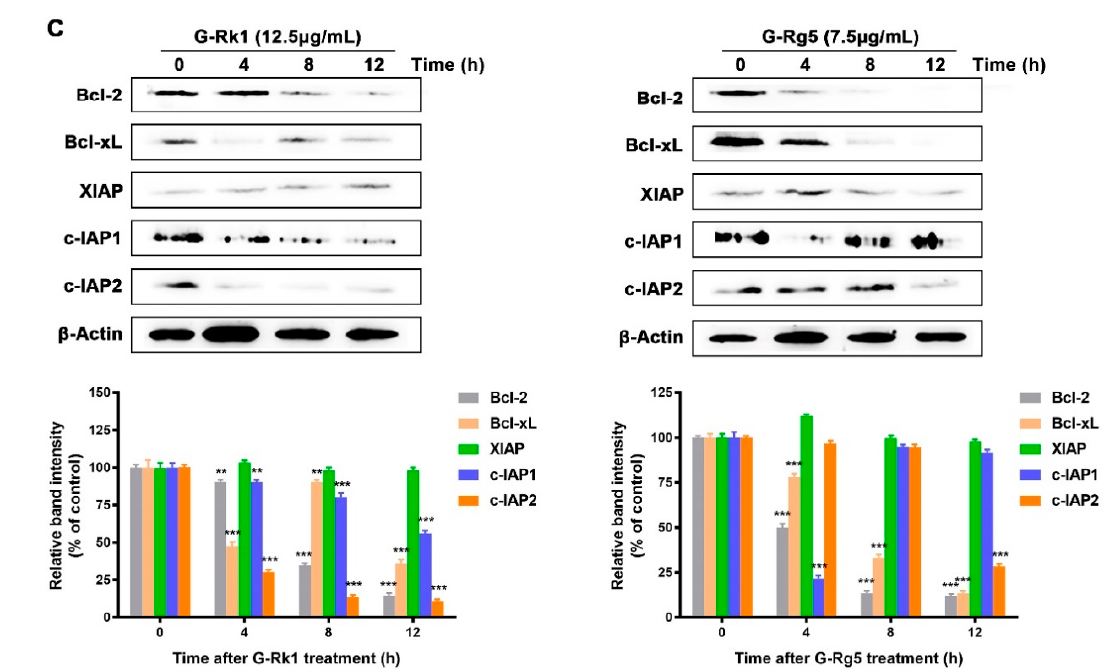
Figure 4. Activation of caspase-8, -9, -3 and analysis of anti-apoptotic protein levels in MHCC-97H cells treated with G-Rk1 or G-Rg5. ( A ) MHCC-97H cells were treated with 12.5 µ g/mL G-Rk1 or 7.5 µ g/mL G-Rg5 for the indicated times. Cell-free caspase-8, -9, -3 activities were analyzed using specific substrates, Ac-IETD-AFC, Ac-LEHD-AFC, and Ac-DEVD-AFC, respectively. ( B ) Immunoblotting analysis of the caspase-3 substrate PARP cleavage in MHCC-97H cells treated with G-Rk1 or G-Rg5 for the indicated times. ( C ) Immunoblotting analysis of the anti-apoptotic protein levels in MHCC-97H cells. The lower panels are quantitative analyses of the above data in ( B , C ). Data are shown as the mean ± SD of experiments performed in triplicate. A Student’s t -test was used for quantitative analysis, and the significance is shown as *** p < 0.001 and ** p <